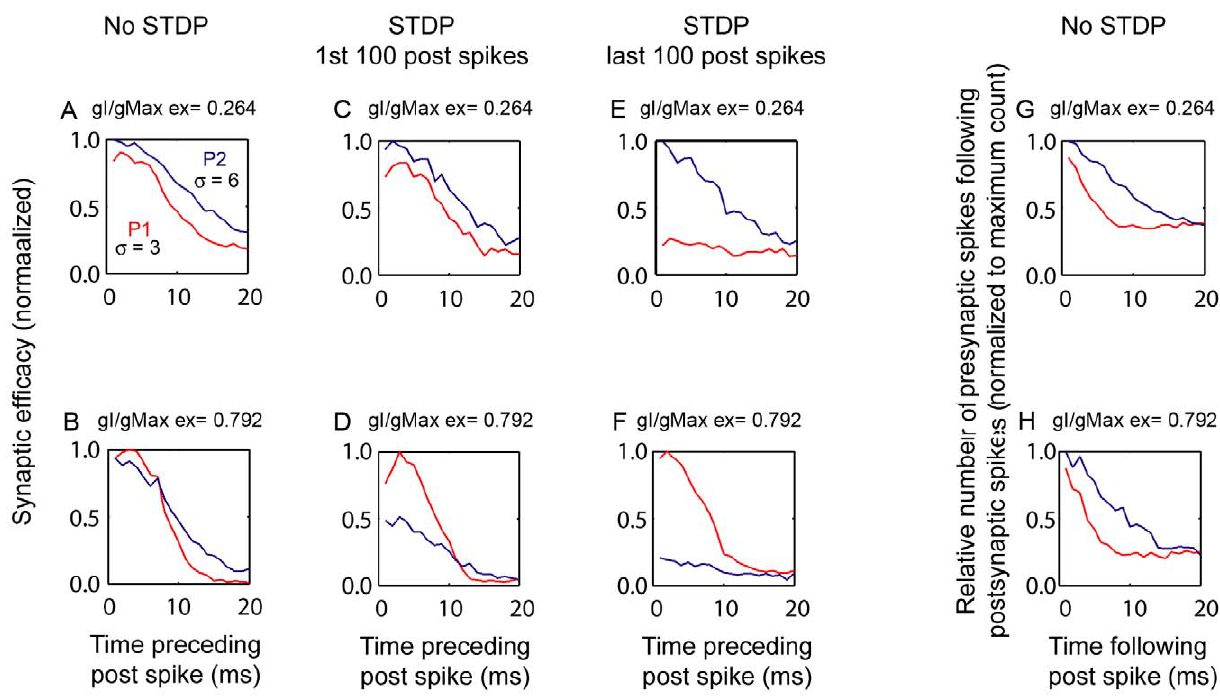
Figure 5. The relative contribution of input pathways with different temporal coherence and initial synaptic strength to postsynaptic spike events is dependent on inhibition. In these simulations, P1 (red, s =3) is more coherent than P2 (blue, s =6), as in Input Regime III (Figure 3G), but is weaker (ISS P2/P1 =1.5). The relative number of presynaptic spikes in P1 or P2 that preceded postsynaptic spike events was counted in 1 millisecond time bins and plotted as a function of time preceding the postsynaptic spike for two levels of inhibition, low (A,C,E, gI/ gmax ex =0.264) and high (B,D,F, gI/gmax ex =0.792). The analysis was first done in the absence (A, B) and then in the presence (C–F) of the STDP learning rule, (C–F) are examples of individual STDP simulations trials. At a low level of inhibition, P2 had a slight advantage in all time bins in the absence of STDP (A), and went on to dominate in 50% of the STDP trials; an example of P2 domination shown in (C, E). At a high level of inhibition, P1 had a slight advantage over P2 in contributing to postsynaptic spike events 2–8 ms preceding the postsynaptic spike (B); and this advantage was dramatically magnified by STDP (D,F). (G–H) The total number of presynaptic spikes in P2 that followed postsynaptic spike events is greater than that in P1 in the absence of STDP learning rules. The relative number of presynaptic spikes was calculated as in (A–B), except that 1 ms bins counts were made for a time window of 20 ms following postsynaptic spikes.